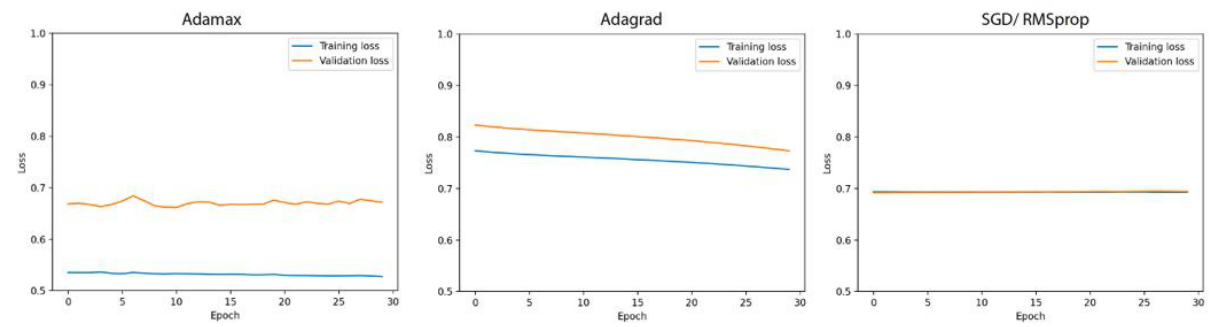
Figure 6. Evolution of the cross-entropy loss function for a range of popular optimizers, using the one-week-long training dataset as a testing ground.